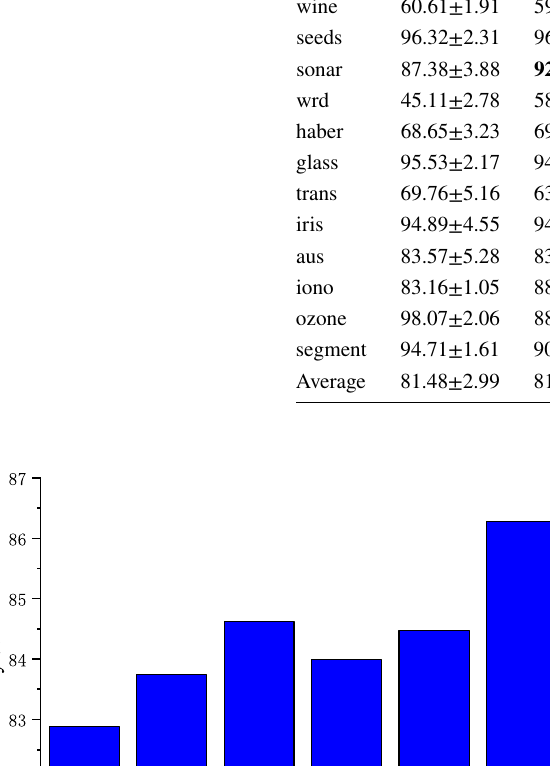
Table 3 Recall on different datasets